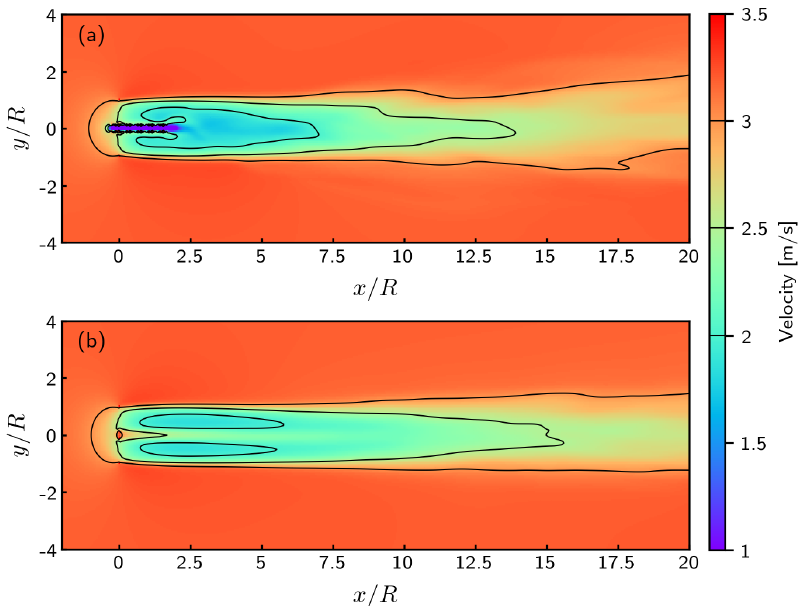
Figure 4. Time-averaged wakes obtained for I ∞ = 1.5%, TSR = 3.67, λ = 4.5 m, σ ( λ ) = 0% and R f = 1. ( a ) with nacelle. ( b ) without nacelle.